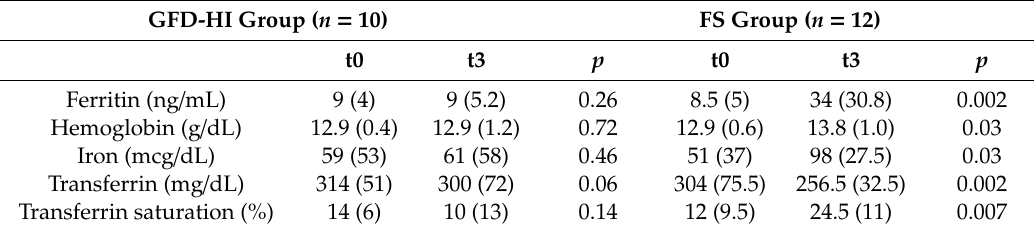
Table 1. Blood tests of the enrolled patients.